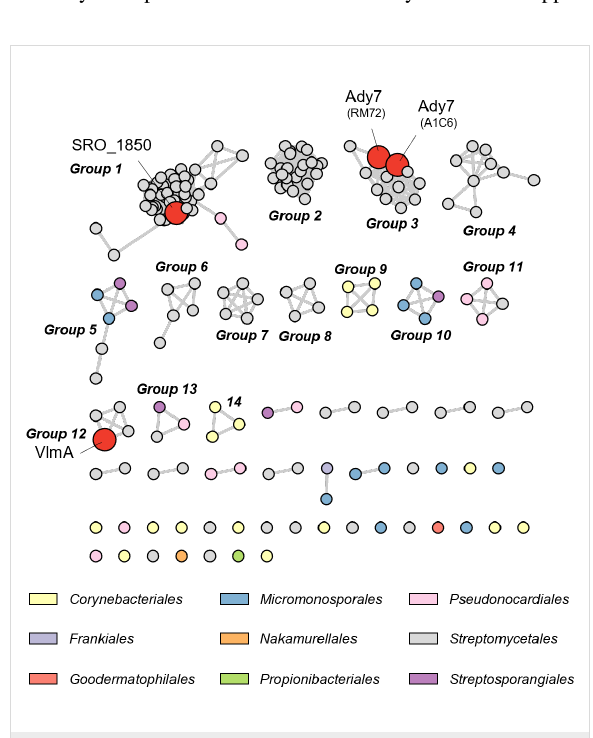
Figure 5: Sequence similarity network of VlmA-like enzymes in the actinobacterial genomes in the Refseq database. Nodes are colored according to the host organism’s order. Enzymes with known biosyn- thetic products are colored